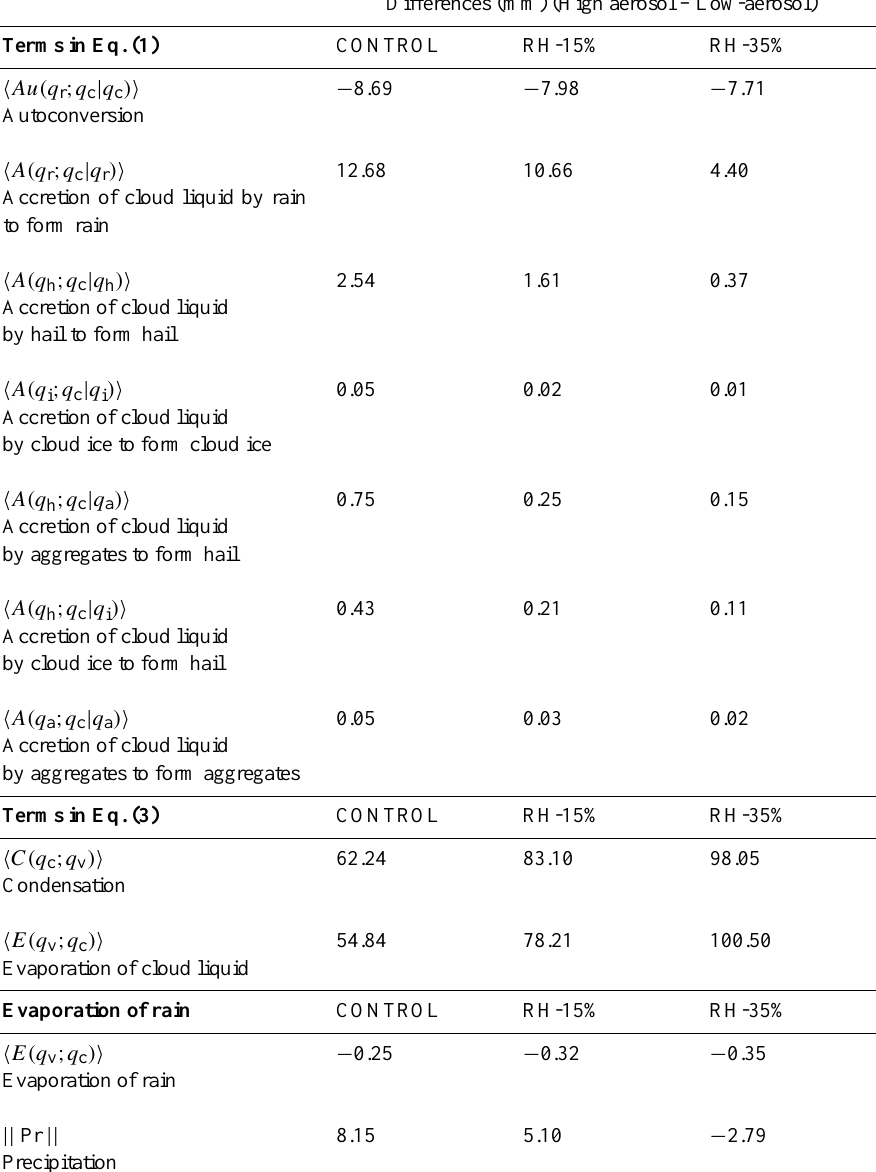
Table 2. Domain-averaged differences in the accumulated sources and sinks of precipitation, retained in the approximated Eqs. (1) and (3), and the domain-averaged differences in the accumulated evaporation of rain between the high- and low-aerosol runs. Differences (mm) (High aerosol – Low-aerosol) Terms in Eq. (1) CONTROL RH-15%